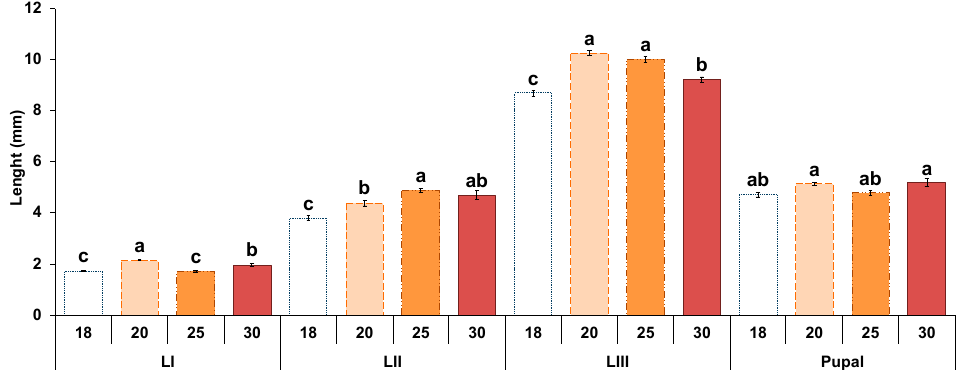
Figure 2. Larval length average in each stage of Hydrotaea capensis at 18, 20, 25 and 30 °C. Letters indicate statistically significant differences (LSD test, p < 0.05) between temperatures of the same stage.